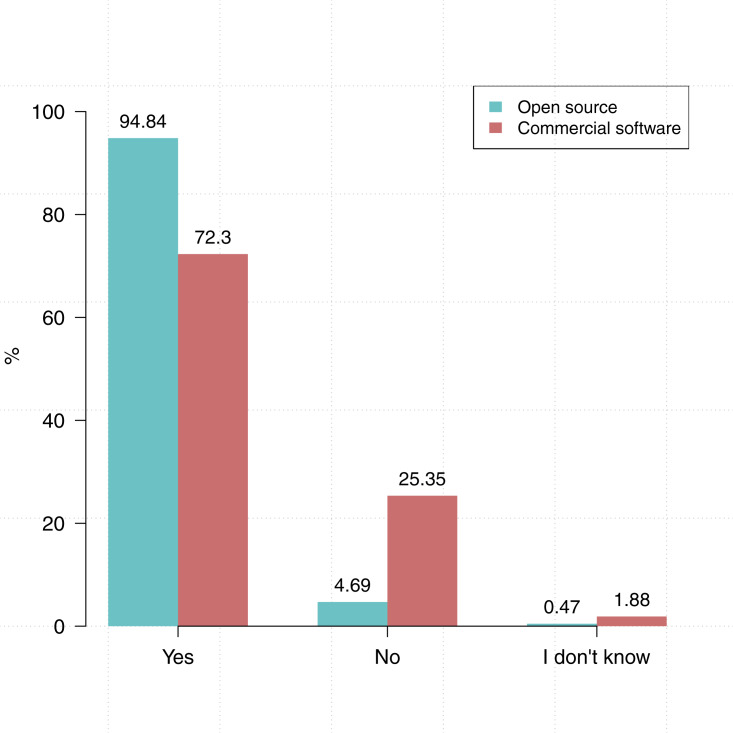
Researchers tends to use open source software (N = 213) more than commercial software (N = 212).